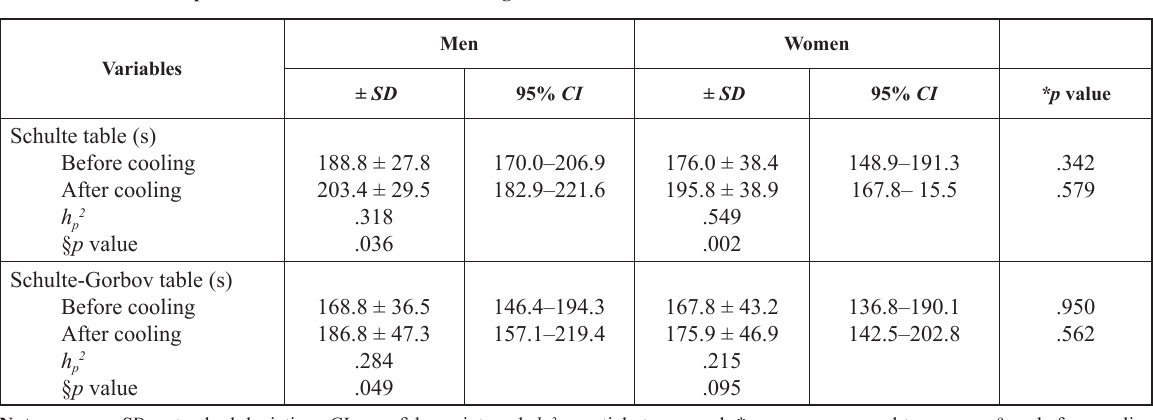
Table 4. Attention task performance before and after cooling